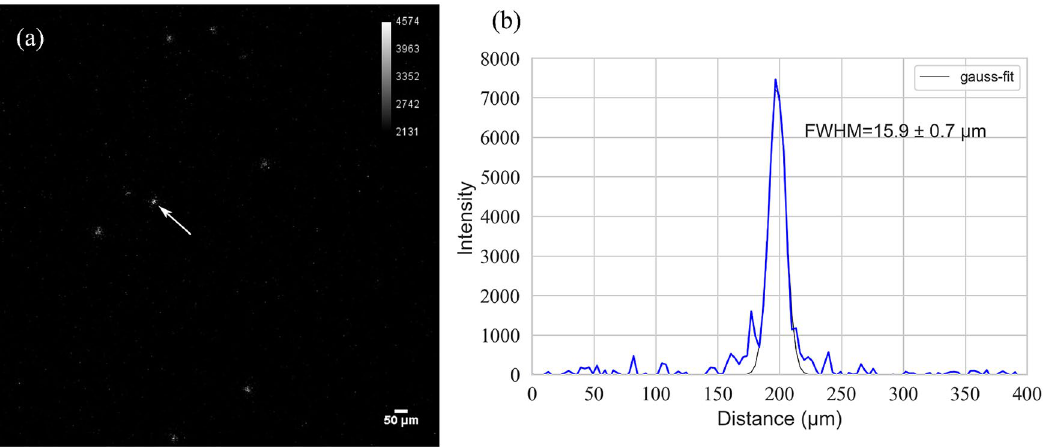
Figure 2. ( a ) Image of an alpha particle captured using the high-resolution alpha imager with a zoom range of 5 ×. ( b ) Intensity profile of the alpha particle with a zoom range of 5 × .